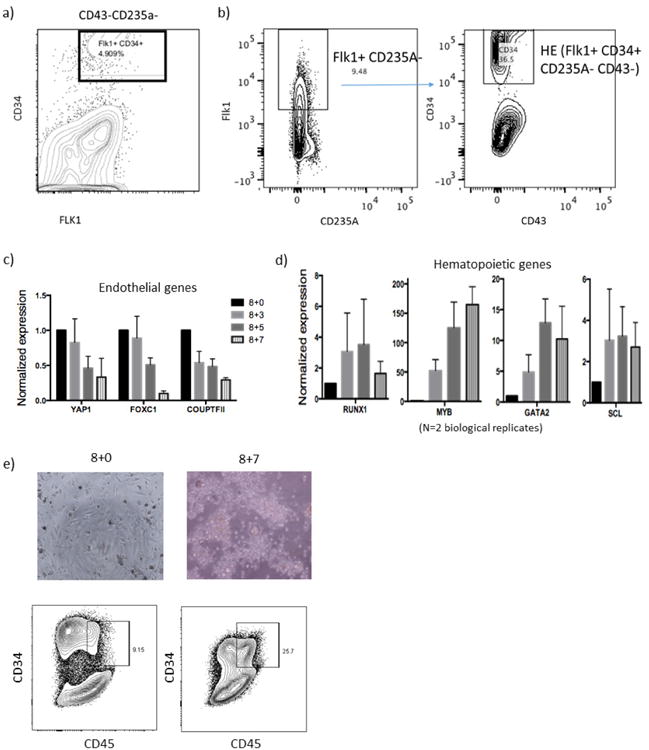
Induction of haemogenic endothelium from hPSCsa, Embryoid bodies formed from hPSCs. Subsequent panels show FACS analysis of day 8 embryoid bodies before magnetic cell isolation. b, CD34+FLK1+ population indicates haemogenic endothelium cells.CD235A and FLK1 plots show percentage of FLK1+CD235A− cells in embryoid bodies, further gated with CD43 and CD34 plots to detect haemogenic endothelium (CD34+FLK1+CD235A−CD43−). c, d, Haemogenic endothelium isolated at day 8 (Supplementary Fig. 1) was further cultured in EHT medium for the indicated number of days. qRT–PCR showed (c) downregulation of endothelial genes and (d) upregulation of haematopoietic genes. HSPC genes (RUNX1, SCL/TAL1) peak on day 3 of EHT culture; consequently, this time point was chosen for introducing transcription factors followed by transplantation in subsequent experiments. e, Microscopy and FACS analysis on day 7 of EHT showed the appearance of haematopoietic cells (CD34+CD45+). Data shown as mean ± s.d.